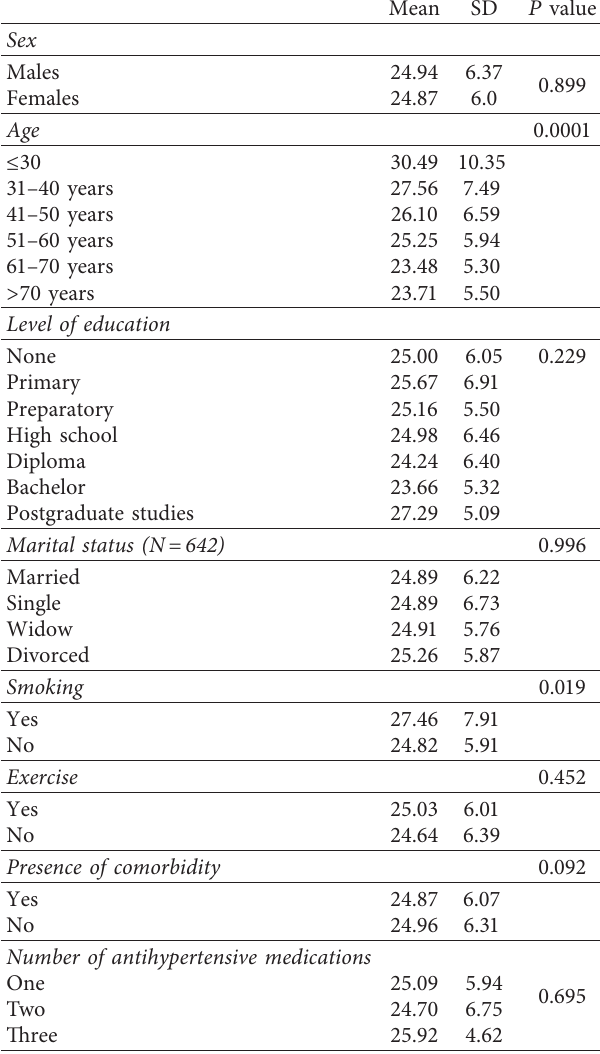
Table 6: Impact of demographic variables on